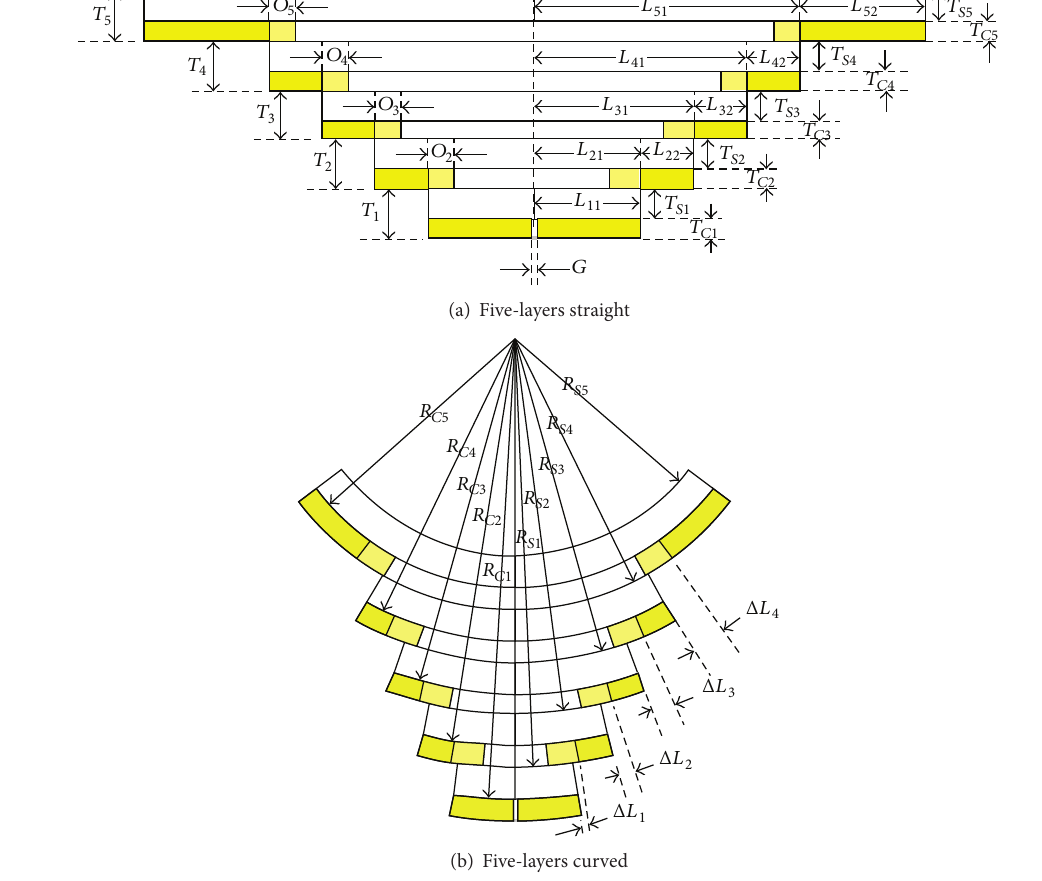
Figure 7: Five-layers strip dipole antenna schematic.